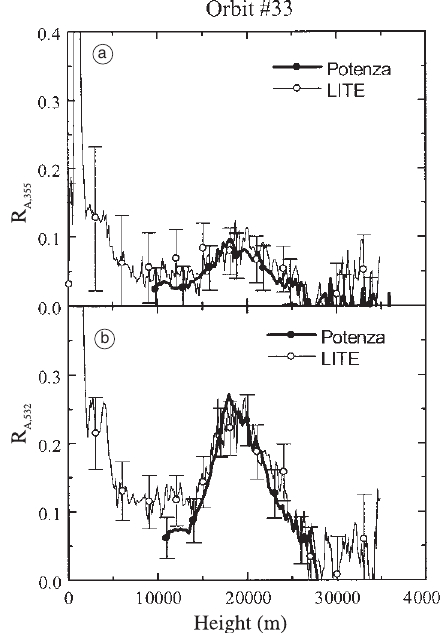
Fig. 6. Simultaneous LITE (thin line) and Potenza (solid line) lidar measurements of the aerosol scattering ratio at 355 nm (a) and 532 nm (b) for orbit 33. Data area reported with their error bars